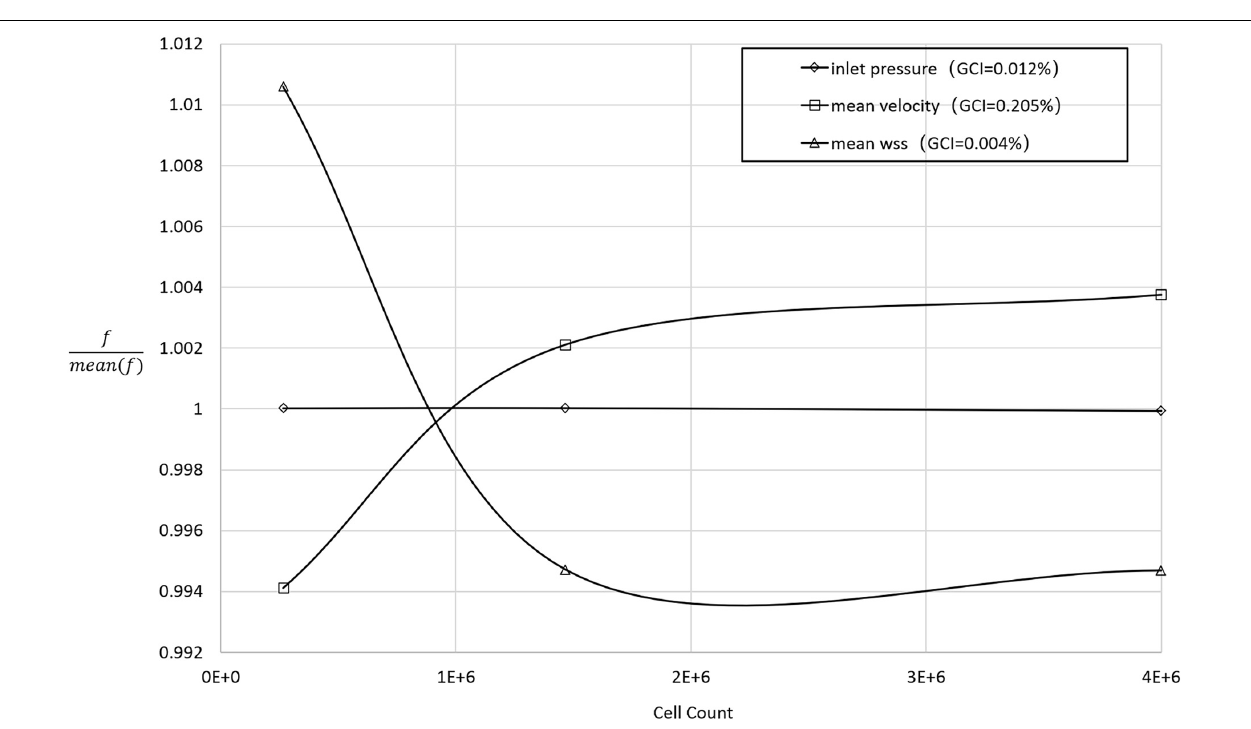
Frontiers in Physiology |